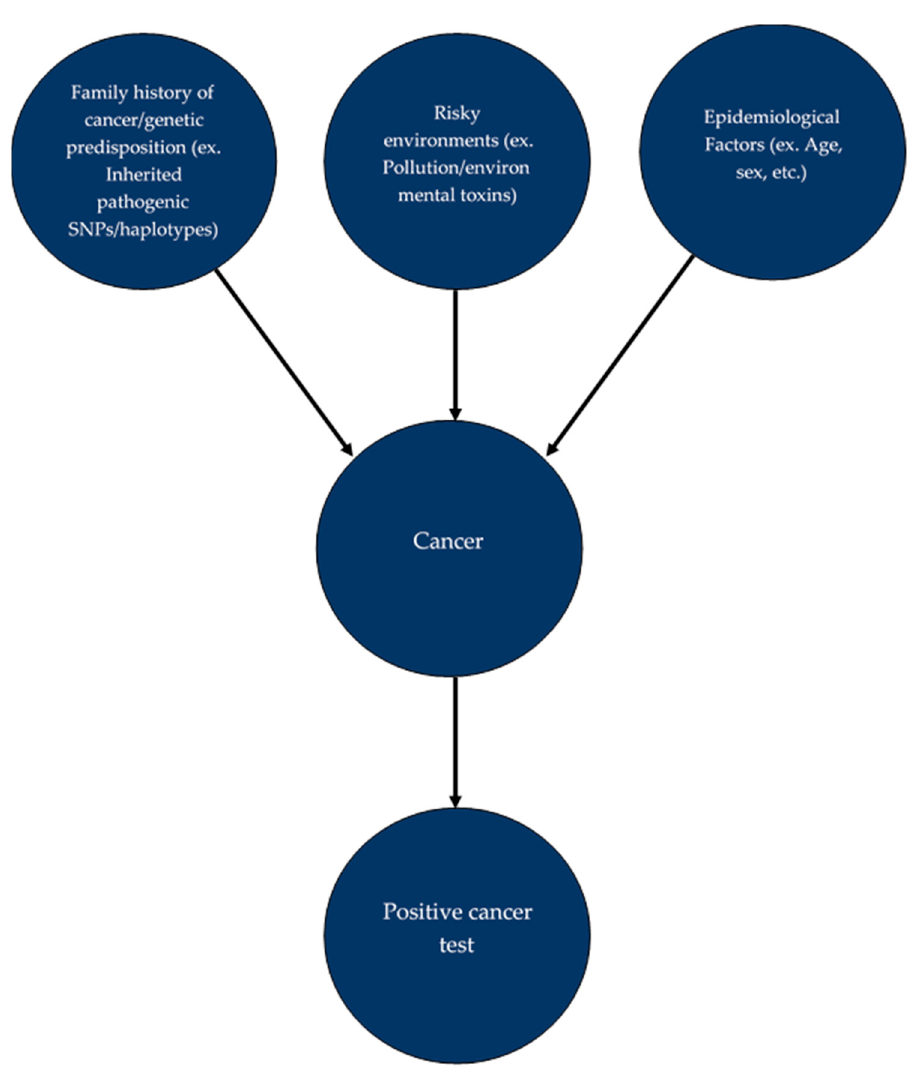
Figure 2. Simple pictorial of a Bayesian network without probabilities.